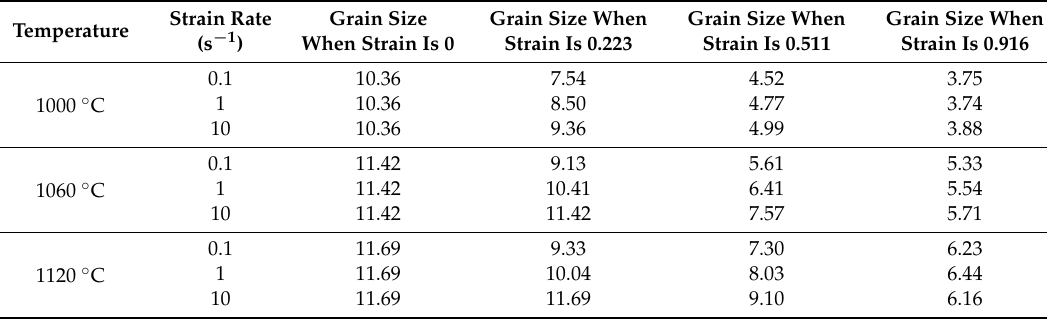
Table 2. Average grain size (in µ m) at different strain rates and